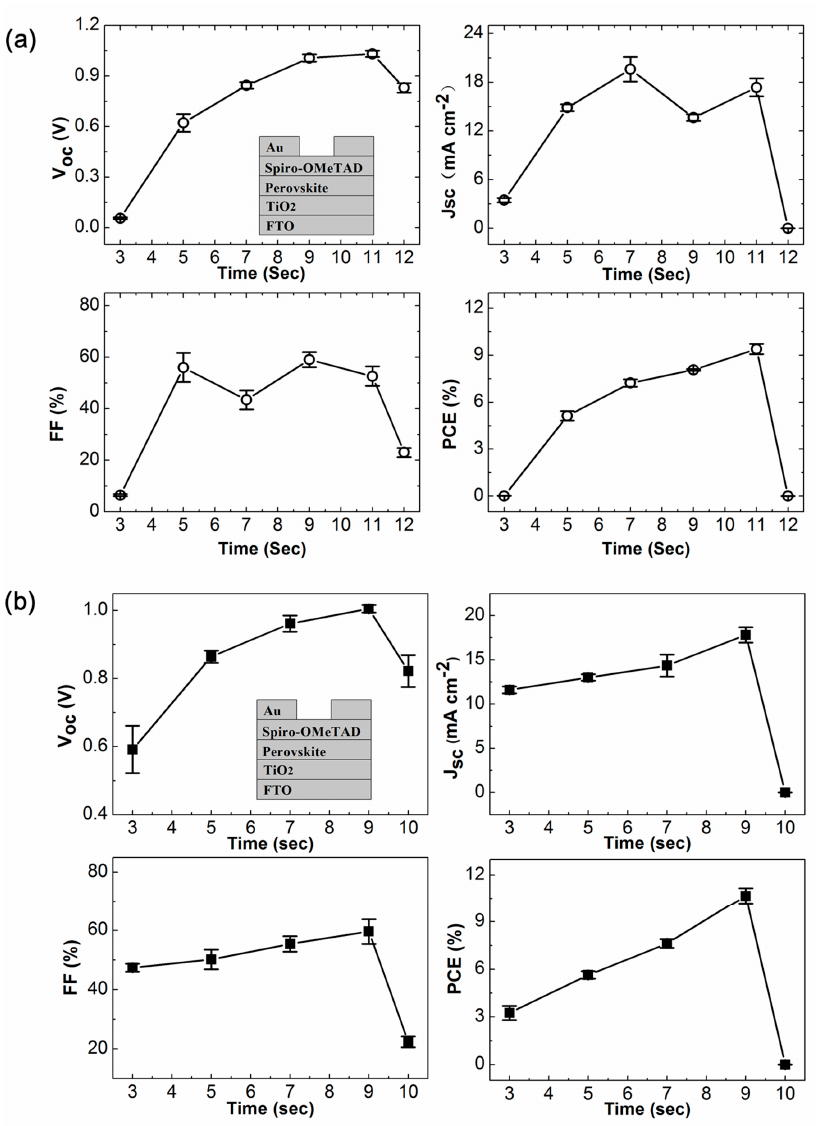
Figure 3. Photovoltaic parameters of the PSC devices employing LiTFSI-doped spiro-OMeTAD HTL with di ff erent exposure time of ( a ) O 2 plasma and ( b ) O 2 / Ar plasma: Open circuit voltage V oc , short circuit current density J sc , fill factor FF and power conversion e ffi ciency PCE . The symbols indicate the average values with the corresponding standard deviation from 5 samples. The insets show the schematic architecture of the complete PSC